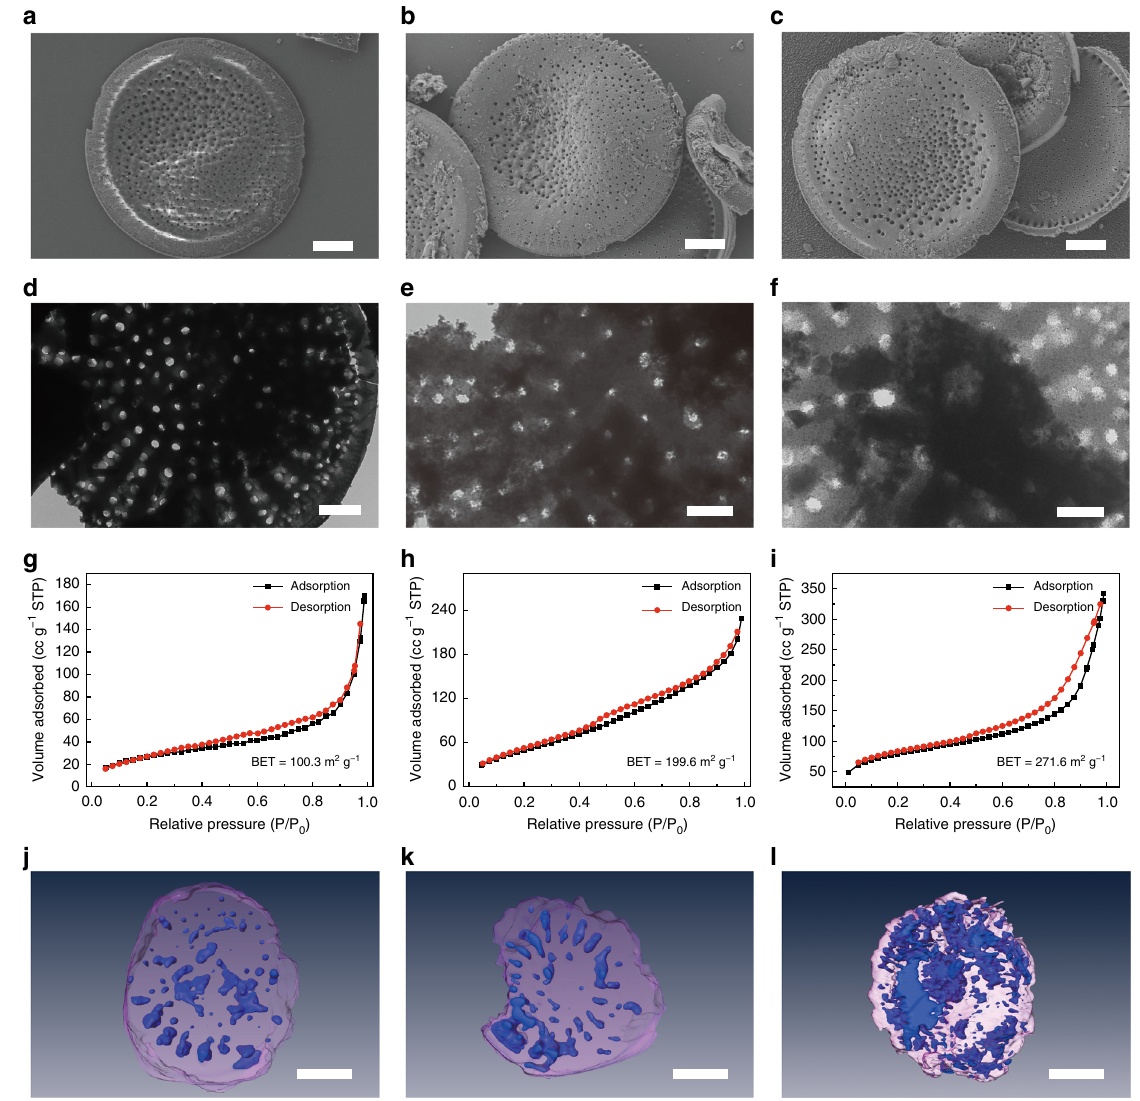
Fig. 2 Morphology and surface area characterizations of pristine DF, DF-SiO, and DF-Si, respectively. a – c SEM images of pristine DF ( a scale bar = 5 μ m), DF-SiO ( b scale bar = 5 μ m), and DF-Si ( c scale bar = 5 μ m), respectively. d – f TEM images of pristine DF ( d scale bar = 1 μ m), DF-SiO ( e scale bar = 500 nm), and DF-Si ( f scale bar = 500 nm), respectively. g – i N 2 adsorption/desorption curves of pristine DF ( g ), DF-SiO ( h ), and DF-Si ( i ), respectively. j – l SXT images of DF ( j scale bar = 2 μ m), DF-SiO ( k scale bar = 2 μ m), and DF-Si ( l scale bar = 2 μ m),